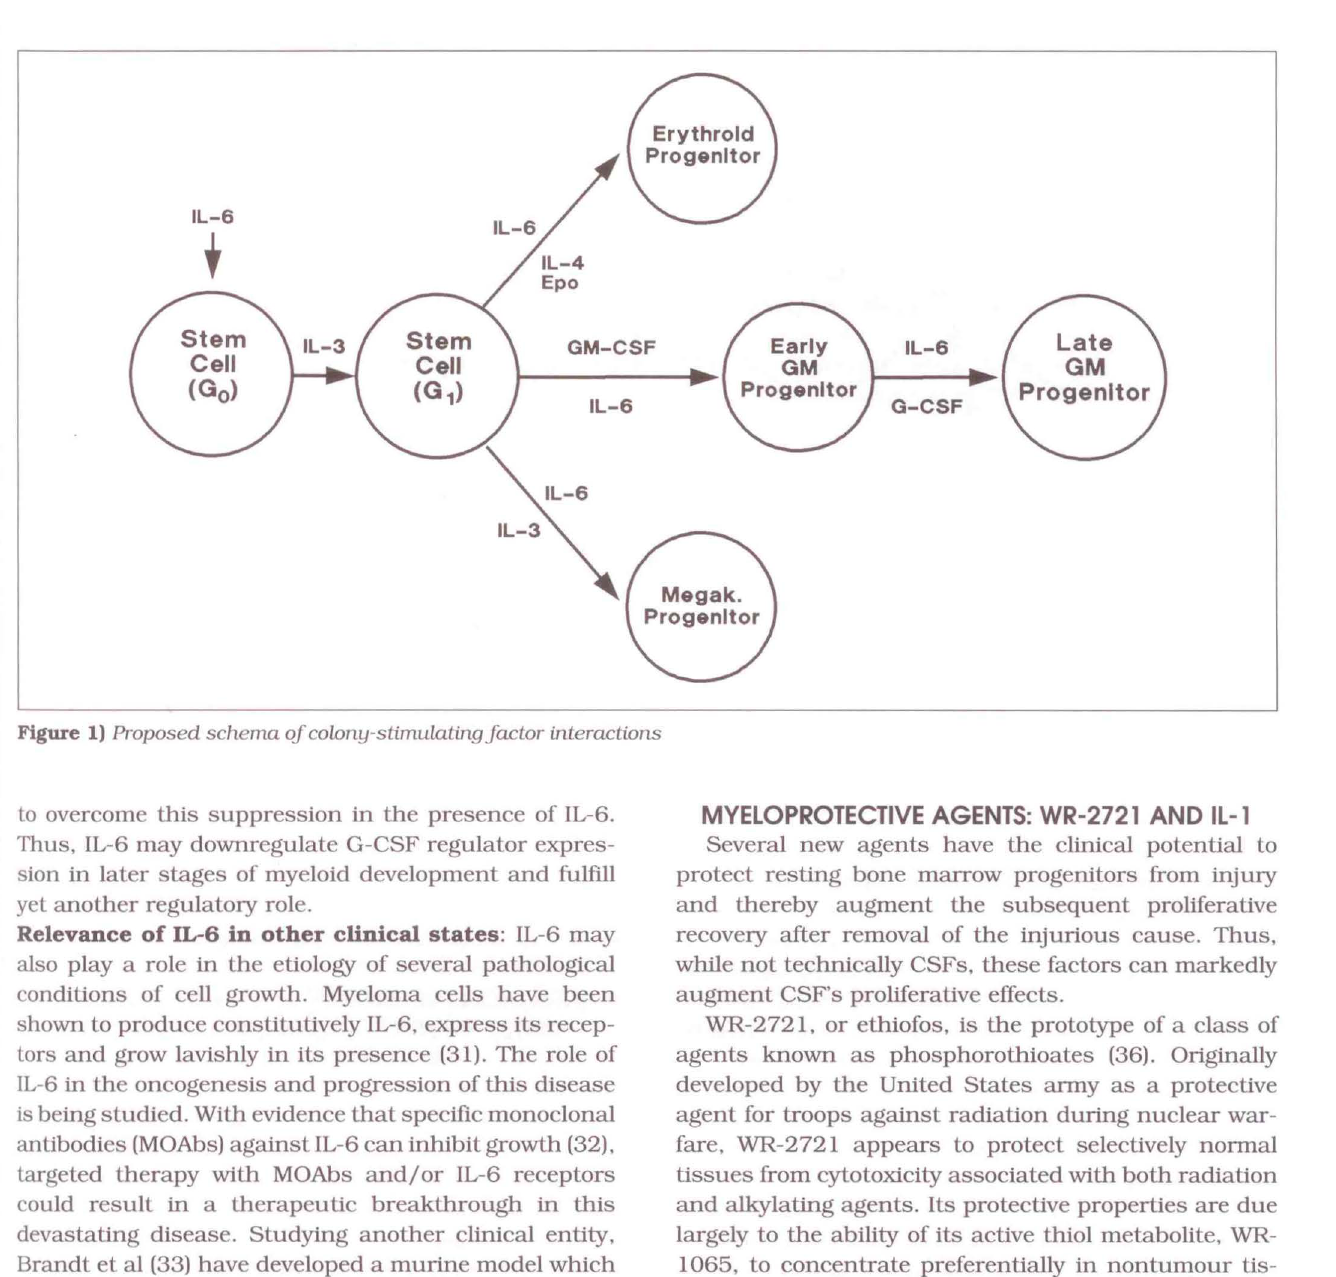
Figure 1) Proposed schema of colony-stimulating factor interactions